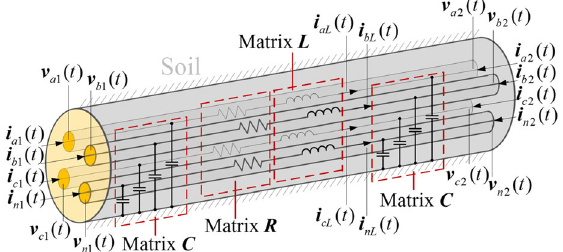
Fig. 24 π -equivalent model of a circuit section (mutual inductances and capacitances are not